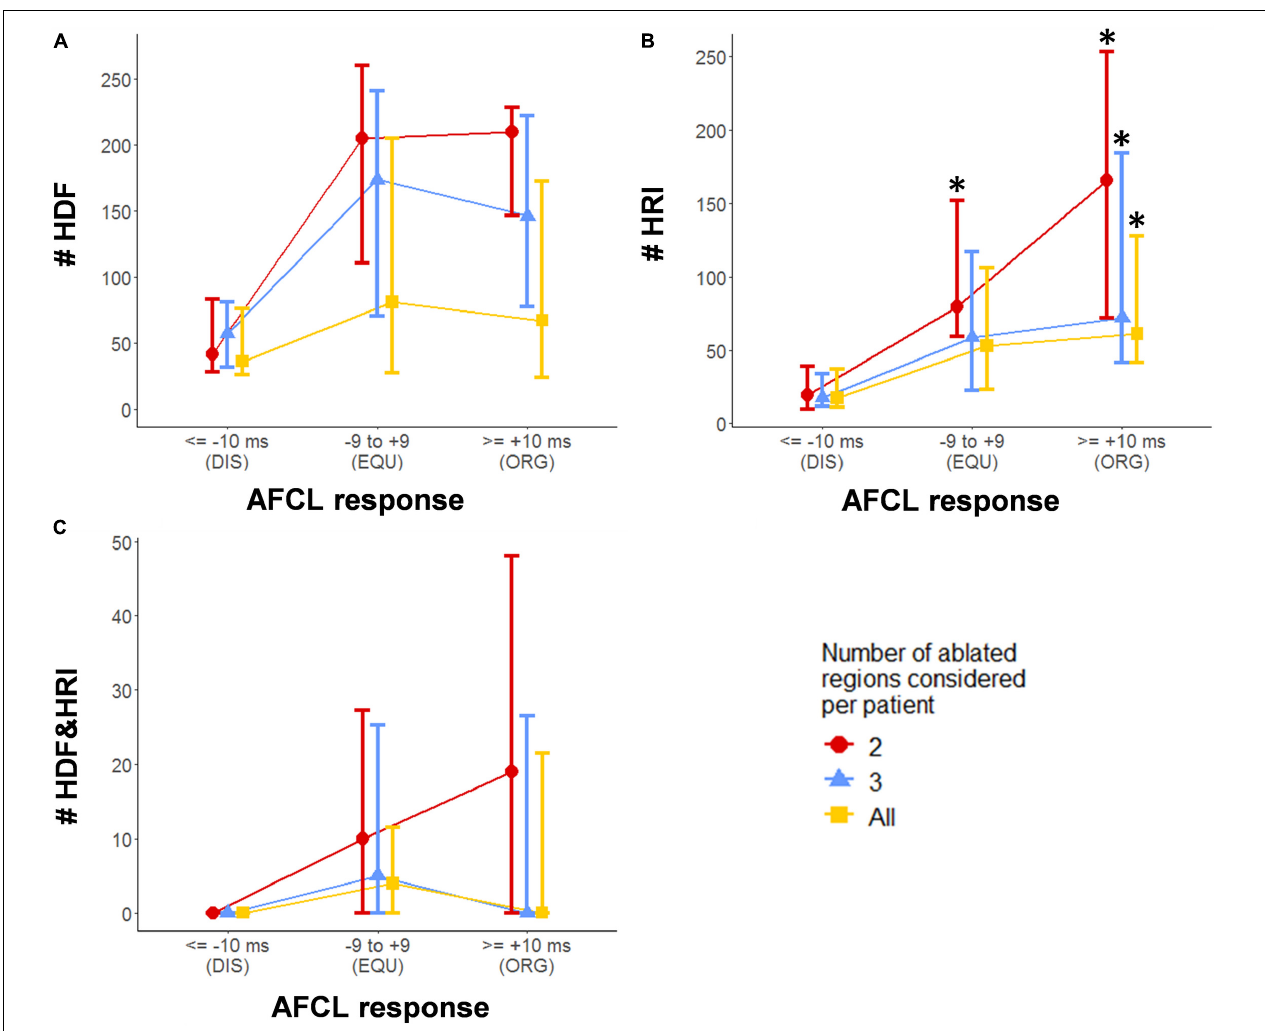
FIGURE 5 | Spectral characteristics of HDF-targeted ablation regions compared with the AFCL response to ablation of that region. (A) HDF counts. (B) HRI counts. (C) HDF + HRI concurrence counts. Values shown are median ± interquartile range. DIS – ablation lesions resulting in an AFCL decrease/disorganization of 10 ms or more; EQU – ablation lesions resulting in equivocal change in AFCL of between –9 and + 9 ms; ORG – ablation lesions resulting in AFCL increase/organization of 10 ms or more; * indicates a statistically significant difference when compared with the corresponding DIS group after correction for multiple comparisons.